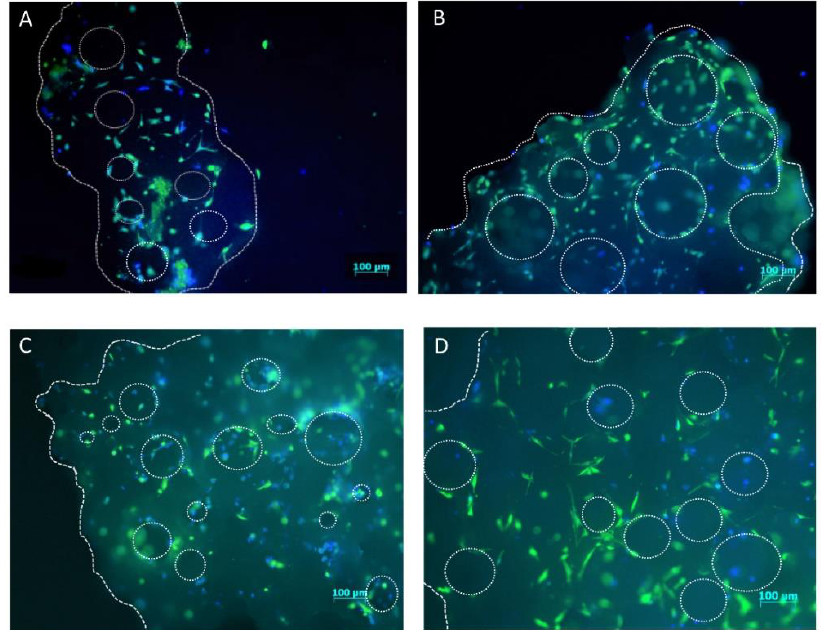
Figure 2. hMSCs distribution on a β -TCP scaffold granule before and post-thawing. Control hMSCs were seeded on a β -TCP scaffold and cultured either for 24 ( A ) or 72 h ( B ). Experimental hMSCs were seeded on a β -TCP scaffold, cultured for 24 h, frozen in liquid nitrogen for seven days, thawed, and cultured for 1 ( C ) and 48 ( D ) hours. All cells are stained with Calcein AM and DAPI. Dotted line shows the edges and pores of β -TCP granule. (5 × magnification; scale bar = 100 µ M).